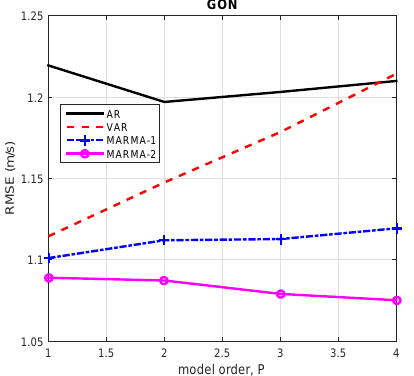
Figure 6. Root mean square error (RMSE) performances of the autoregressive (AR), vector autoregressive (VAR) and multi-channel autoregressive moving average (MARMA) models with respect to model order P when m = 3 (GONEN) and ∆ = 2 h.